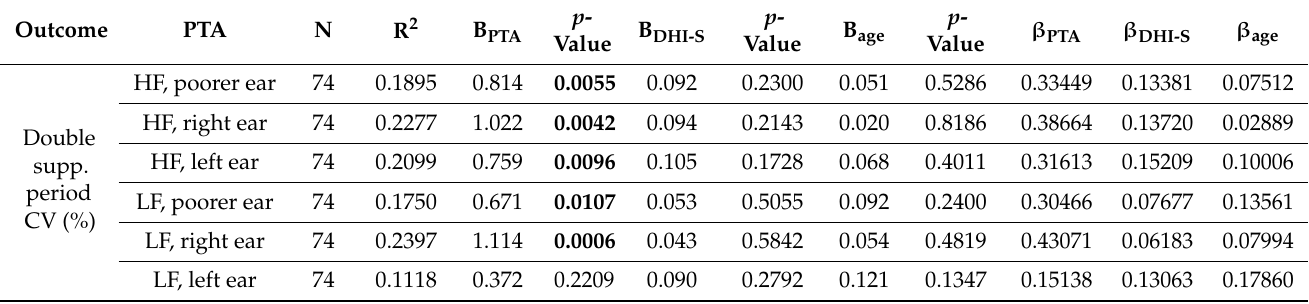
Table 3. Multiple regression models for the outcome double support period CV for 10 dB increases in different hearing